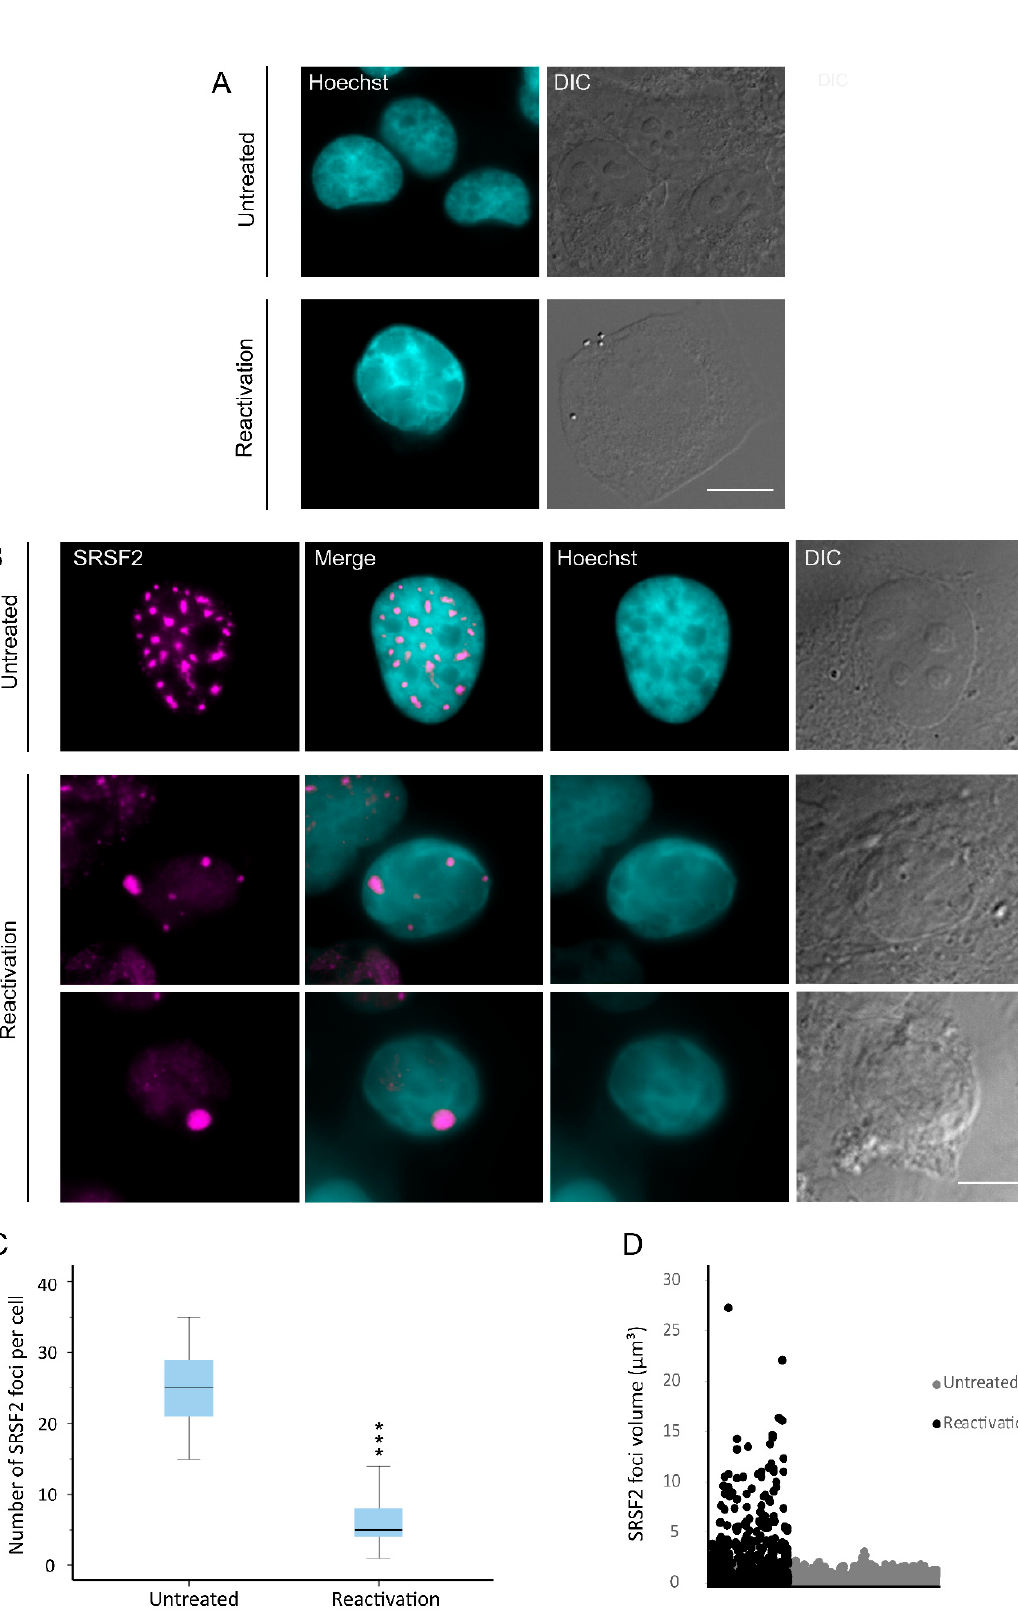
Figure 1. Redistribution of nuclear speckles to the nuclear periphery during lytic reactivation of KSHV. BAC16-infected iSLK cells were treated with Dox and n-Butyrate for 72 h to induce lytic reactivation. Untreated infected iSLK cells were used as a control. ( A ) Condensation and marginalization of chromatin was evident upon lytic reactivation (bottom row) by Hoechst staining (cyan; DIC in grey) as compared with control uninduced cells (top row). Nuclear speckles were stained with anti-SRSF2 (magenta). ( B ) A reduction in the number of nuclear speckles in conjunction